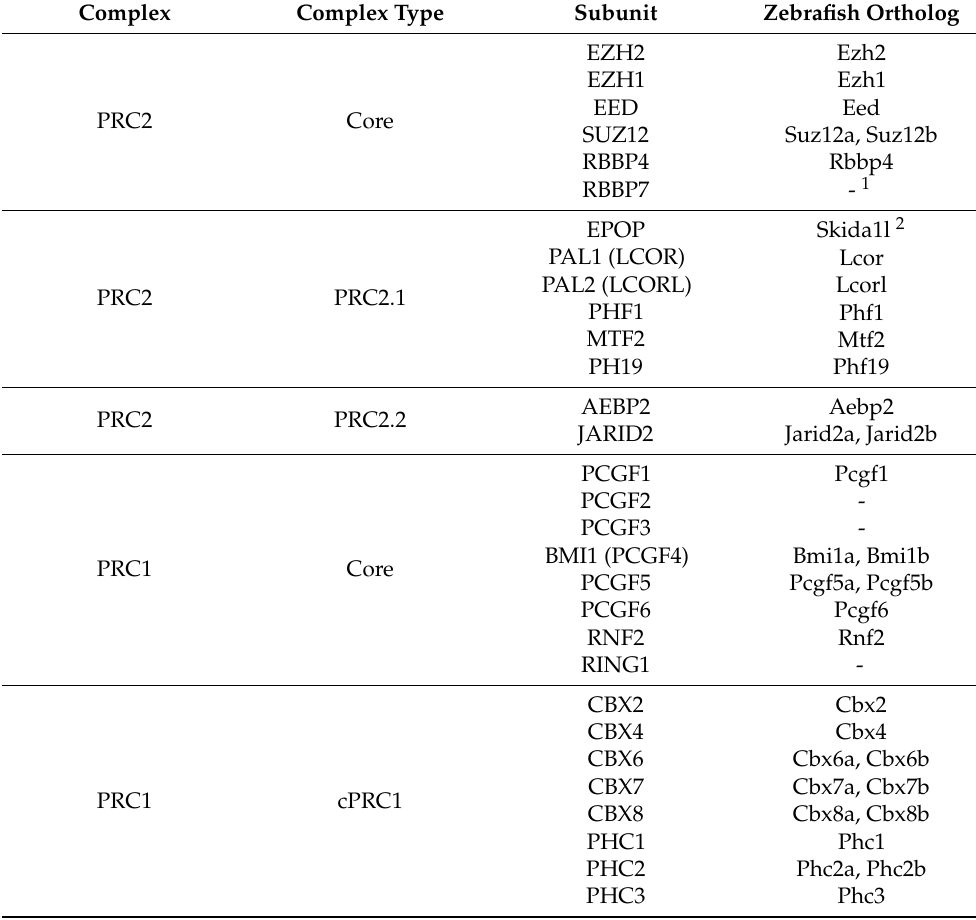
Table 1. Zebrafish genes coding for the PRC2 and PRC1